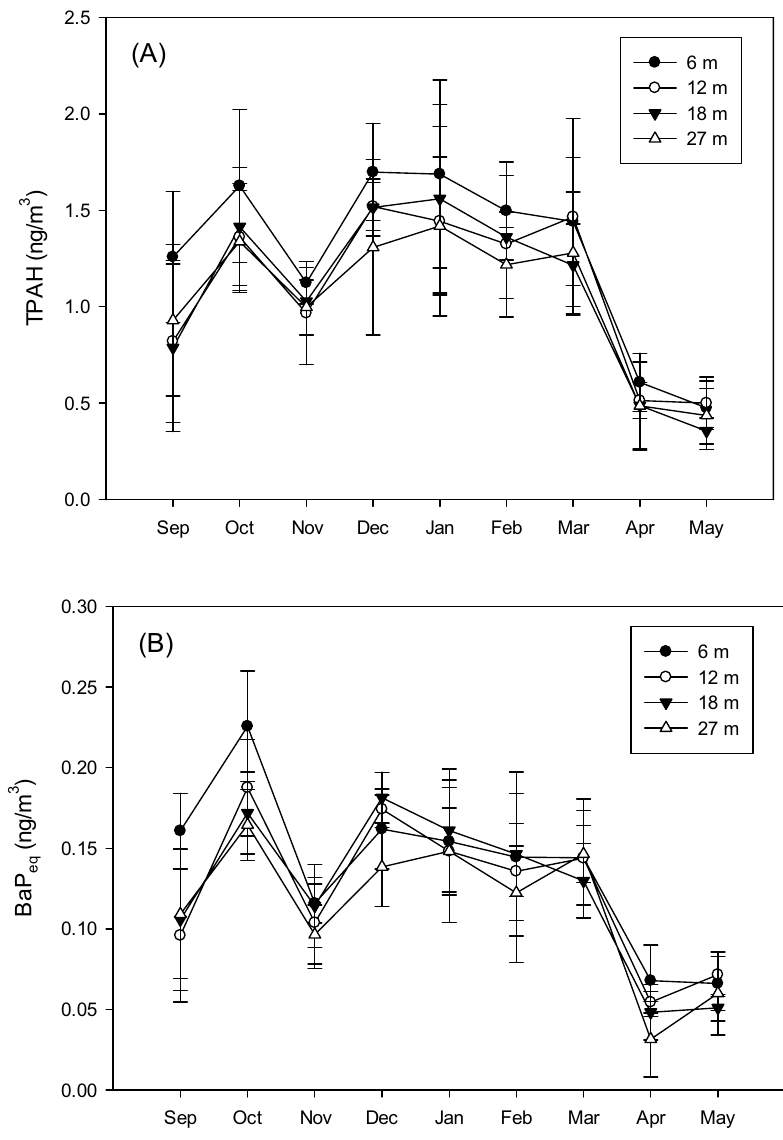
Figure 4. Concentrations of ( A ) PM 2.5 -associated PAH and ( B ) BaP eq in different